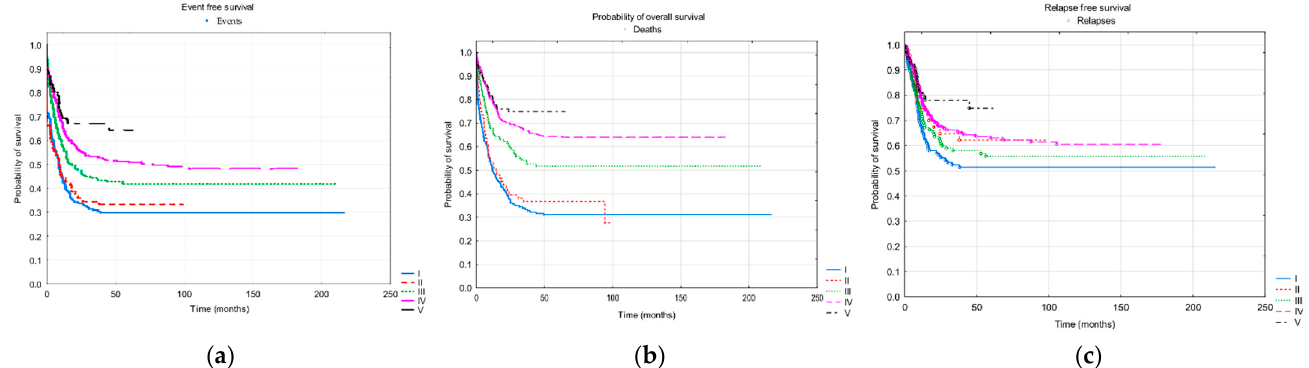
Figure 3. Probability of survival in the consecutive periods: (I) AML-PPLLSG 83, (II) AML-PPLLSG 94, (III) AML-PPLLSG 98, (IV) AML-BFM 2004 Interim, (V) AML-BFM 2012 Registry. Statistically significant differences (log-rank test) are marked. ( a ) Probabilities of three-year overall survival ± standard deviations (SD): 0.34 ± 0.03, 0.37 ± 0.05, 0.54 ± 0.04, 0.67 ± 0.03, and 0.75 ± 0.05 in periods I − V, respectively. Statistically significant differences (log-rank test) between periods I and III ( p = 0.0003), IV ( p < 0.000001), and V ( p < 0.000001); II and III (0.01129), IV ( p < 0.000001), and V ( p < 0.000001); III and IV (0.00661) and V ( p = 0.00076). ( b ) Probabilities of three-year event free survival ± SD: 0.31 ± 0.03, 0.34 ± 0.05, 0.44 ± 0.04, 0.53 ± 0.03, and 0.67 ± 0.05 in periods I − V, respectively. Statistically significant differences (log-rank test) between periods I and III ( p = 0.00518), IV ( p < 0.00001), and V ( p < 0.00001); II and IV ( p = 0.00117) and V ( p < 0.00001). ( c ) Probabilities of three- year relapse-free survival counted for patients who achieved morphological remission ± SD: 0.52 ± 0.03, 0.65 ± 0.05, 0.58 ± 0.04, 0.66 ± 0.03, and 0.78 ± 0.05 in periods I–V. Statistically significant differences (log-rank test) between periods I and IV ( p = 0.03464) and V ( p = 0.00103), and IV and V ( p = 0.01403).